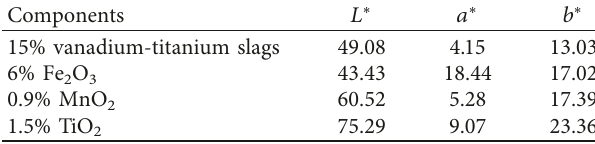
Table 2: Color parameters of ceramics with different components.